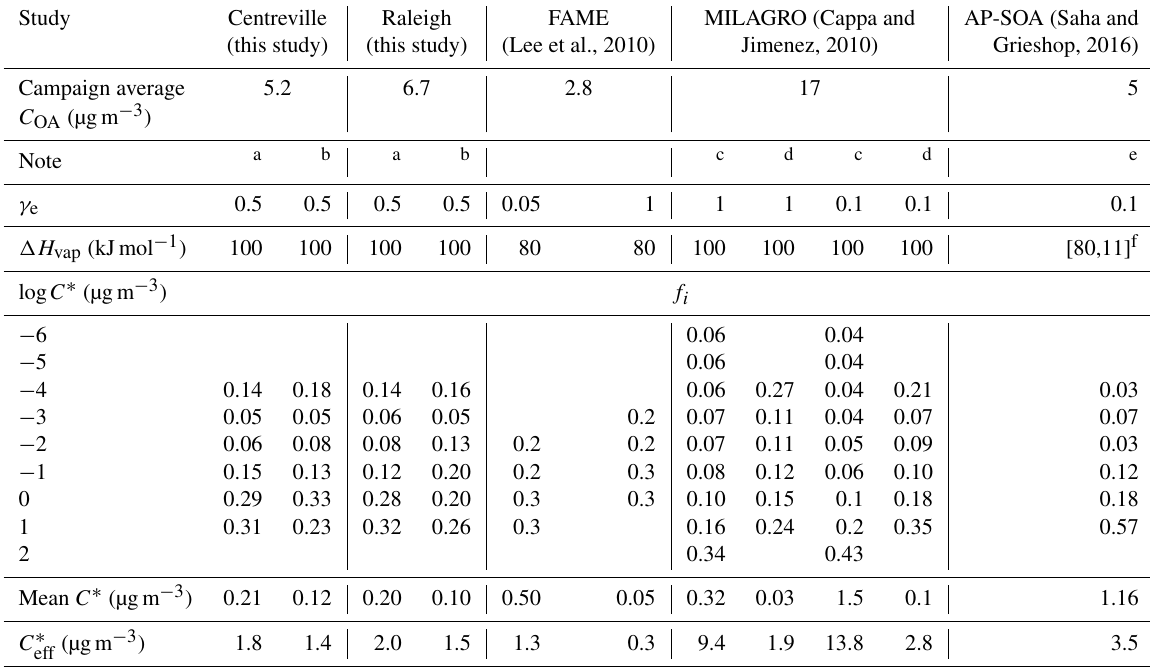
a Campaign-average dual-TD data fit with campaign-average C OA and d p . b Unified fit of individual measurements from whole campaign (MFR, C OA , d p ; 20–30min resolution data). c The f i distribution derived from C i, tot = a 1 + a 2 exp [ a 3 ( log (C ∗ ) − 3 ) ] ; f i = C i, tot /(cid:54)C i, tot ; a 1 , a 2 , and a 3 coefficients were taken from Table 1 of Cappa and Jimenez (2010). log 10 C ∗ bin ranged from − 6 to + 2, as in Cappa and Jimenez (2010). ∗ bin range of − 4 to + 1 to be consistent with the bin ranges used in this study. To do so, materials in log d Same as c , but only considered log 10 C assigned to − 4 bin, material at log 10 C ∗ = 2 bin is excluded, and distribution is renormalized to make (cid:54)f i = 1 . e Chamber-generated SOA from low- C OA α -pinene ozonolysis experiment applying renormalization approach described in note d to the distribution given in Saha and Grieshop (2016) Supplement, Table